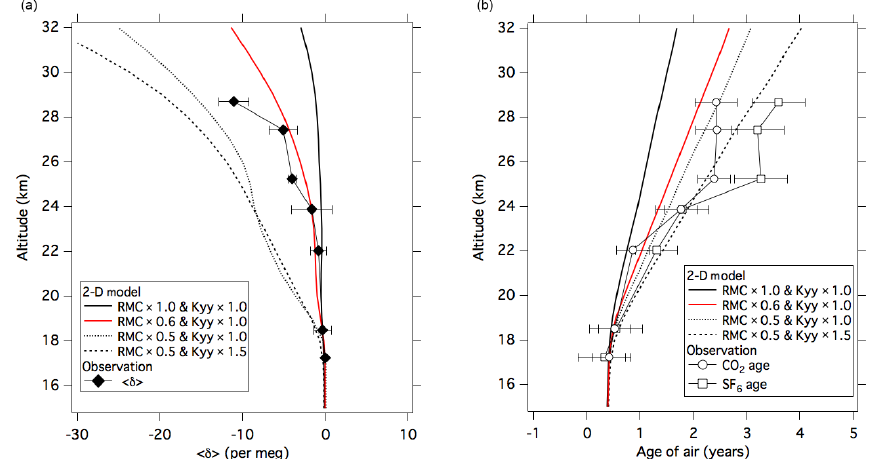
Figure 8. (a) Average vertical profiles of < δ > over the Equator for DJF calculated using the SOCRATES model as a standard run (black solid line), suppressed residual mean circulation (RMC) runs (red line and black dotted line), and suppressed residual mean circulation and enhanced horizontal eddy diffusion ( K yy ) run (black dashed line). The < δ > values observed over Biak are also plotted (closed diamonds). (b) Same as in panel (a) but for the age of air. The observed CO 2 and SF 6 ages are shown as open circles and squares, respectively. Model results are shifted so that the age values at 17km are equal to CO 2 age observed at 17.2km.